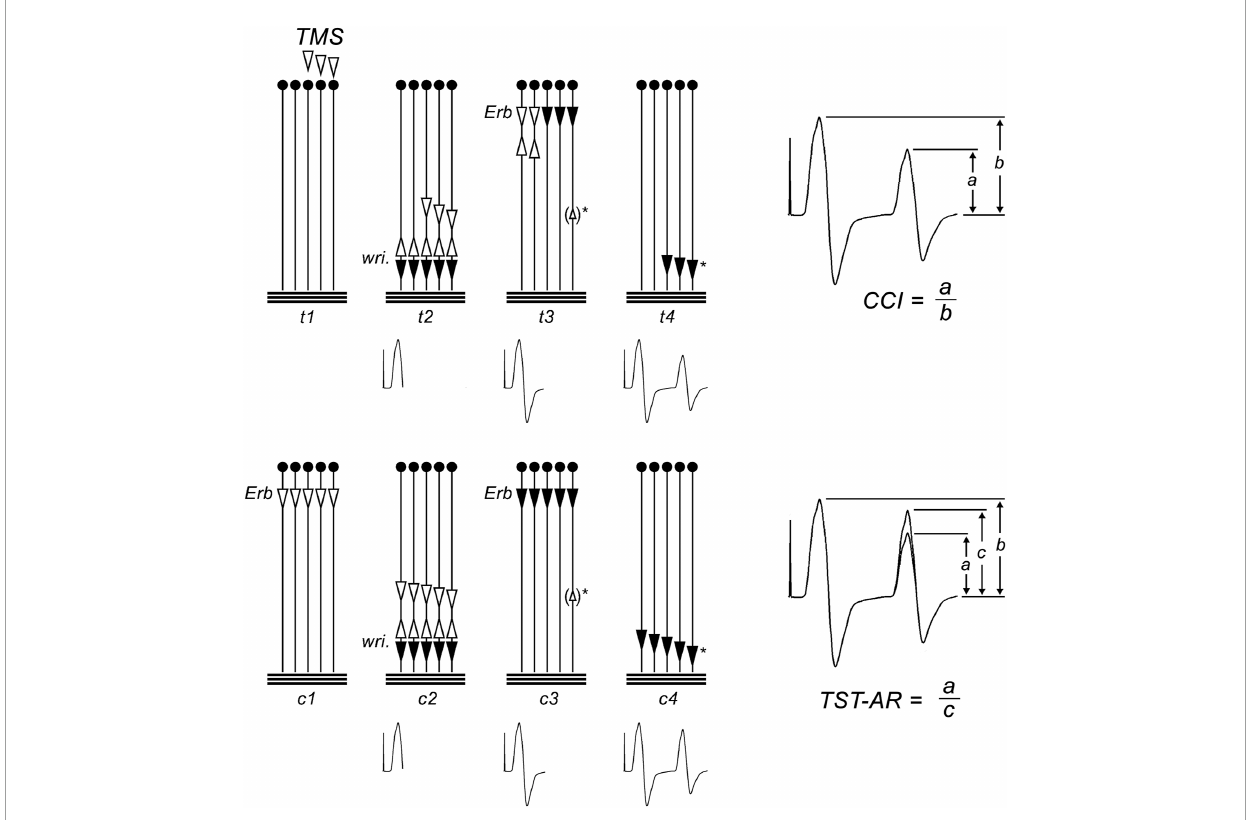
FIGURE 1 Triple stimulation technique (TST) principle. The motor tract is simplified to 5 spinal motor neurons (MNs); horizontal lines represent the muscle fibers of the target abductor digiti minimi (ADM) muscle. Black arrows represent action potentials (APs) that cause a trace deflection, open arrows those that do not. Below, the trace recording is given at each time point. Upper panel: TST test recording and calculation of the central conduction index (CCI); (t1) submaximal TMS excites 3 of 5 MNs. (t2) On 3/5 MNs, TMS induced APs descend. The 3 APs are not synchronous. After a delay, a supramaximal stimulus is applied to the ulnar nerve at the wrist (wri). It gives rise to a first negative deflection of the recording trace. The antidromic APs collide with the descending APs on MNs 3, 4, and 5. The AP on MNs 1 and 2 continue to ascend. (t3) After a second delay a supramaximal stimulus is given to the brachial plexus at Erb’s point. On MNs 1 and 2, the descending APs collides with the ascending APs. On neurons 3–5, no collision occurs, and APs descend. During their descent, a minor degree of desynchronization occurs, as typical for peripheral nerves. In some subjects, ephaptic muscle-nerve backfiring will occur (small open arrow in brackets)*, causing an AP to ascend on neuron 5. (t4) APs on MNs 3–5 cause a second negative deflection of the recording trace. Note that MNs 3–4 were those initially excited by the transcranial stimulus. The response is smaller than the first deflection because it results only fom 3 of the 5 MNs. It is additionally reduced because some desynchronisation of APs will occur during conduction from Erb’s point to the wrist, and because backfiring causes ascending APs (△) * which will collide with some of the descending APs. The CCI is calculated as the ratio of second and first deflection (CCI = a/b; right panel). Lower panel: TST control recording and calculation of the TST amplitude ratio (TST-AR); (c1) a maximal stimulus is given at Erb’s point. (c2) After a delay, a supramaximal stimulus at the wrist causes a first negative deflection of the